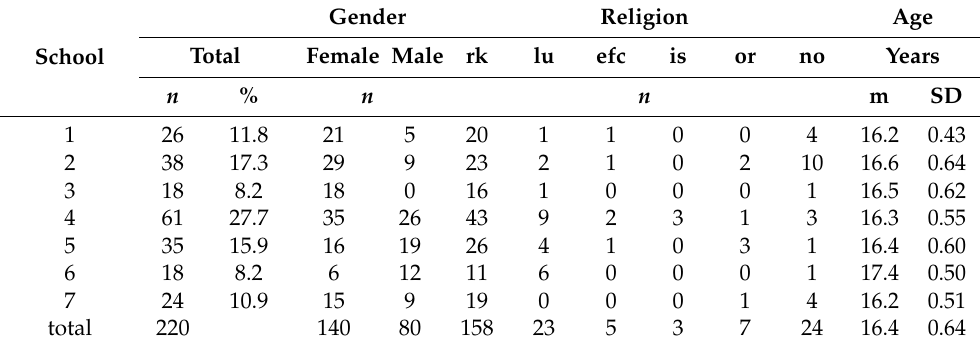
Table 1. Sample characteristics (gender, religion, mean age with standard deviation) by